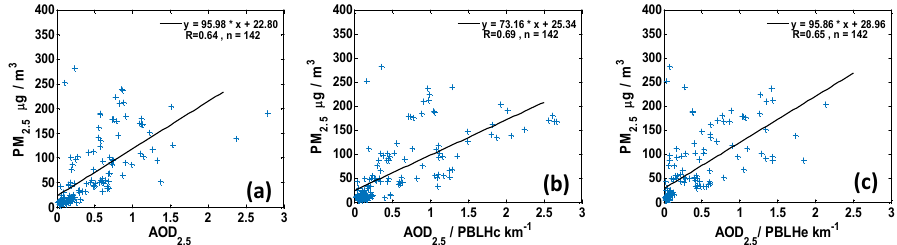
Figure 6. Vertical correction performance with PBLH from CALIPSO (PBLHc) and ECMWF (PBLHe).